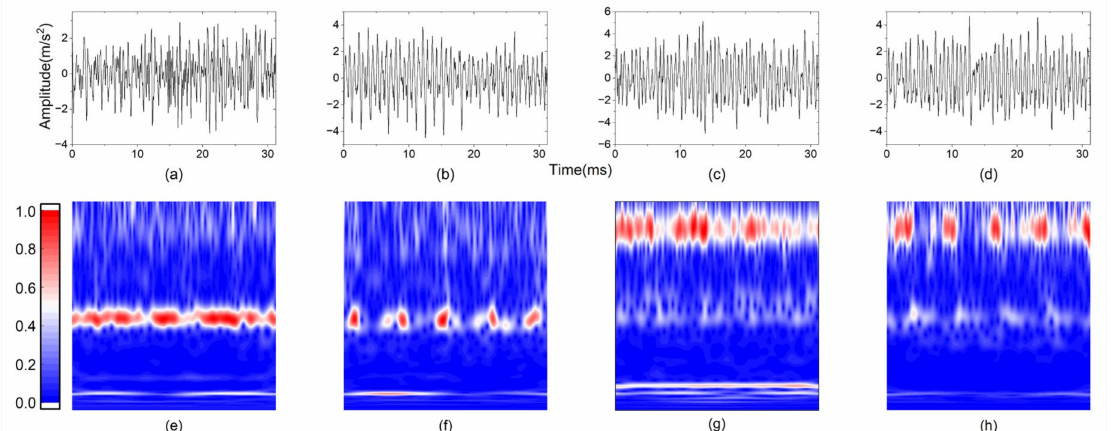
Figure 5. Vibration signals and T-F spectrums in the four health conditions: ( a , e ) NS marked by characteristic band in meshing frequency bin; ( b , f ) RP marked by characteristic patches occurring with meshing frequency in meshing frequency bin; ( c , g ) MA marked by high energy in 2 × meshing frequency bin; ( d , h ) CO marked by characteristic patches occurring with meshing frequency in 2 × meshing frequency bin.